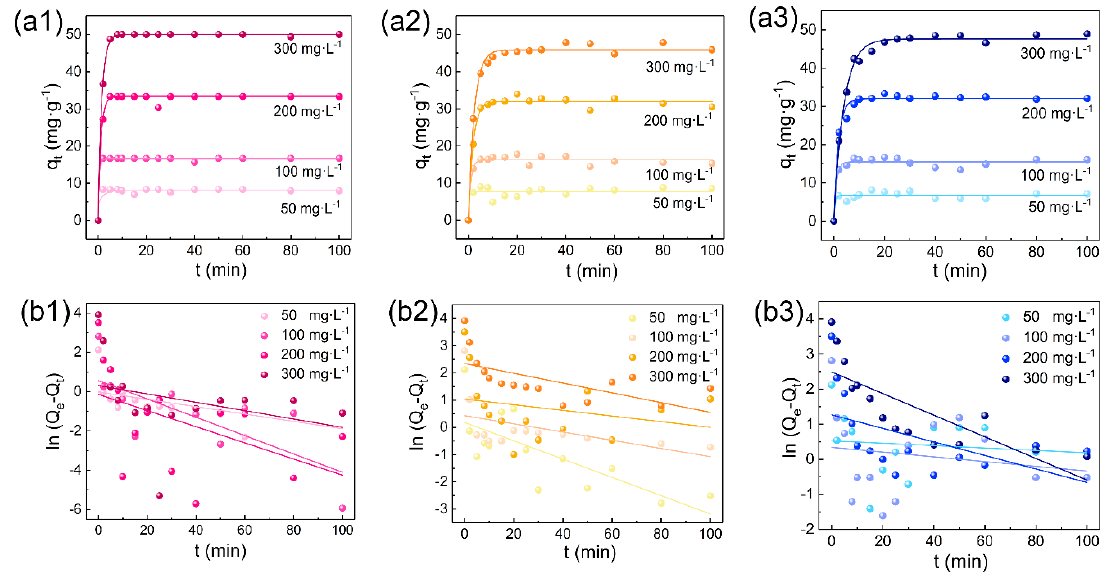
Figure 7. Effect of contact time on the adsorption of ( a1 ) RR120, ( a2 ) RY167, and ( a3 ) RB222, respectively (m = 0.3 g, V = 50 mL, C 0 = 50, 100, 200, and 300 mg·L − 1 , T = 30 °C, pH = 3.0); pseudo-first order kinetics for the adsorption of ( b1 ) RR120, ( b2 ) RY167, and ( b3 ) RB222 onto the CL powders, respectively (m = 0.3 g, V = 50 mL, C 0 = 50, 100, 200, and 300 mg·L − 1 , T= 30 °C, pH = 3.0).